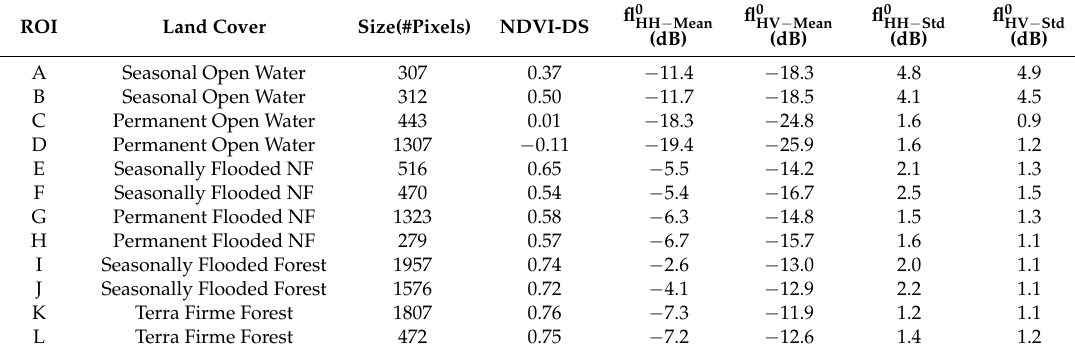
Figure 4. False-color composite of temporal mean ALOS2 PALSAR-2 ScanSAR backscatter (Red: HH, Green: HV, Blue: HH/HV) with locations of ROIs. Table 1. Characteristics of selected ROIs and descriptive summaries of dry season NDVI and multi-temporal γ 0 statistics